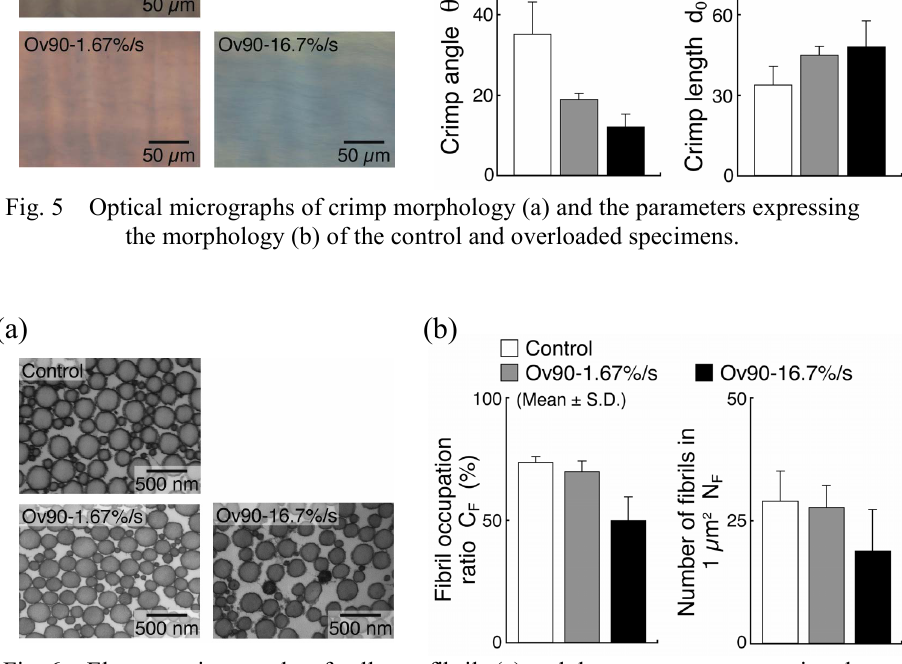
Fig. 6 Electron micrographs of collagen fibrils (a) and the parameters expressing the fibrillar structure (b) of the control and overloaded